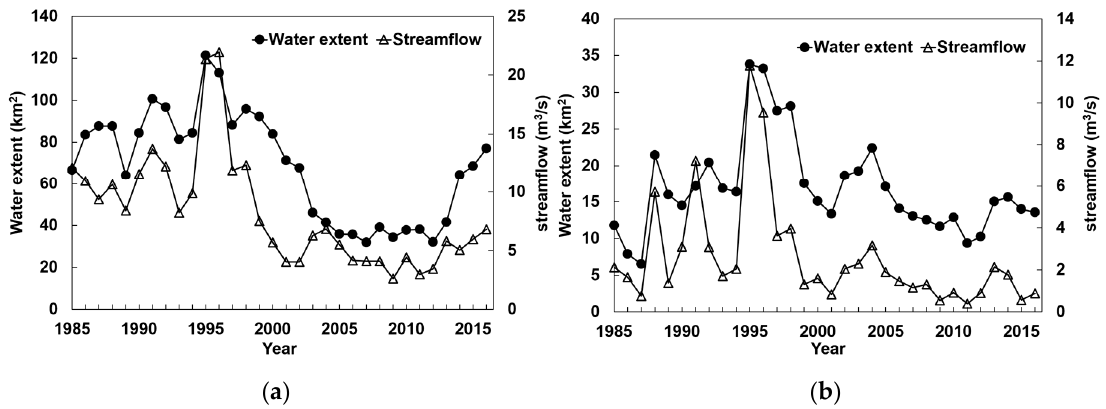
Figure 6. Water extent and inflow for ( a ) Guanting and ( b ) Cetian reservoirs.